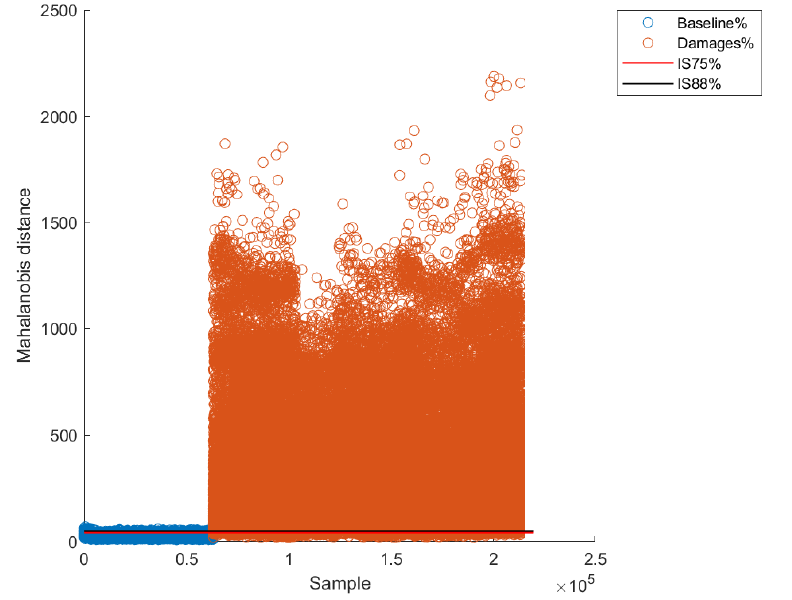
Figure 16. Confidence intervals for excitation frequency of 17.5 Hz.